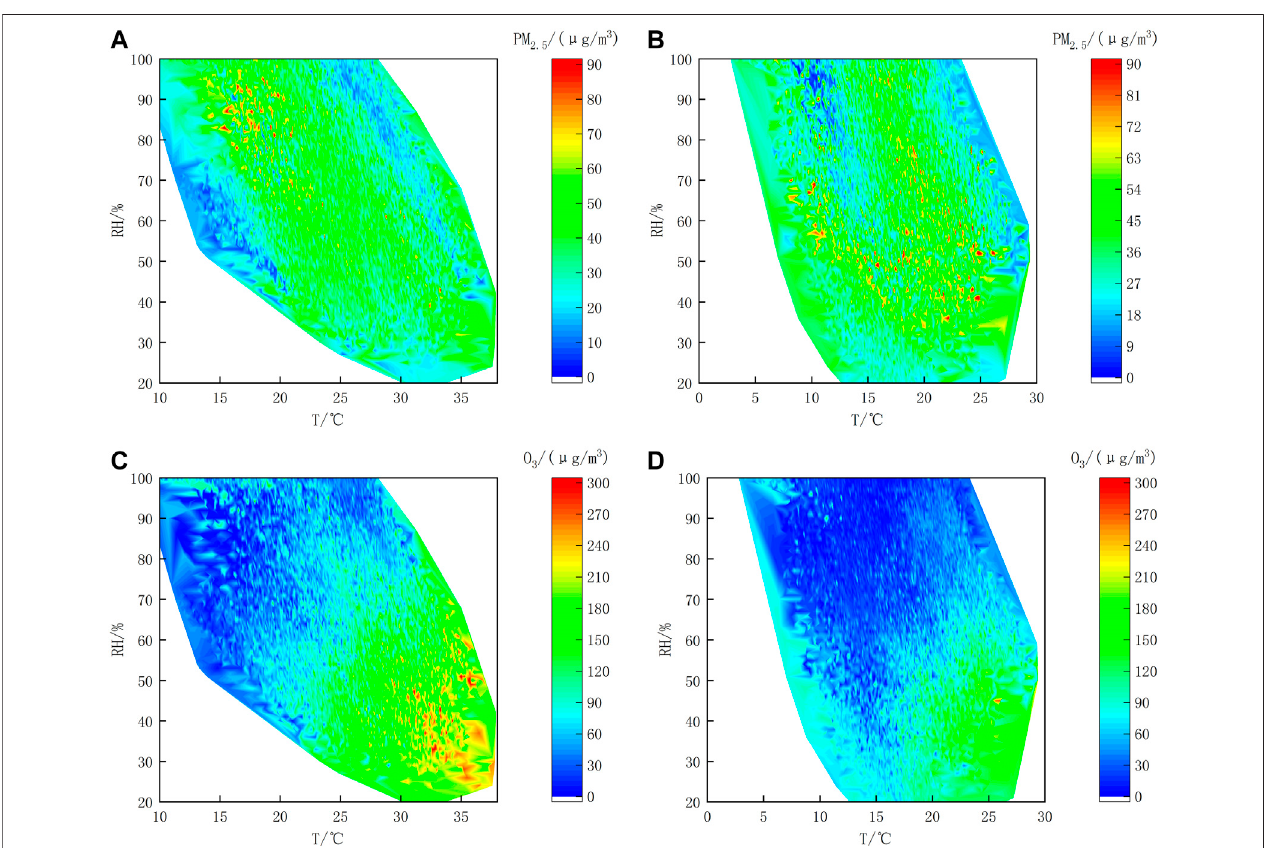
FIGURE 3 | Variations of PM 2.5 and ozone with temperature and humidity in autumn and winter. (A) . PM 2.5 in autumn, (B) . PM 2.5 in winter, (C) . ozone in autumn, and (D) . ozone in